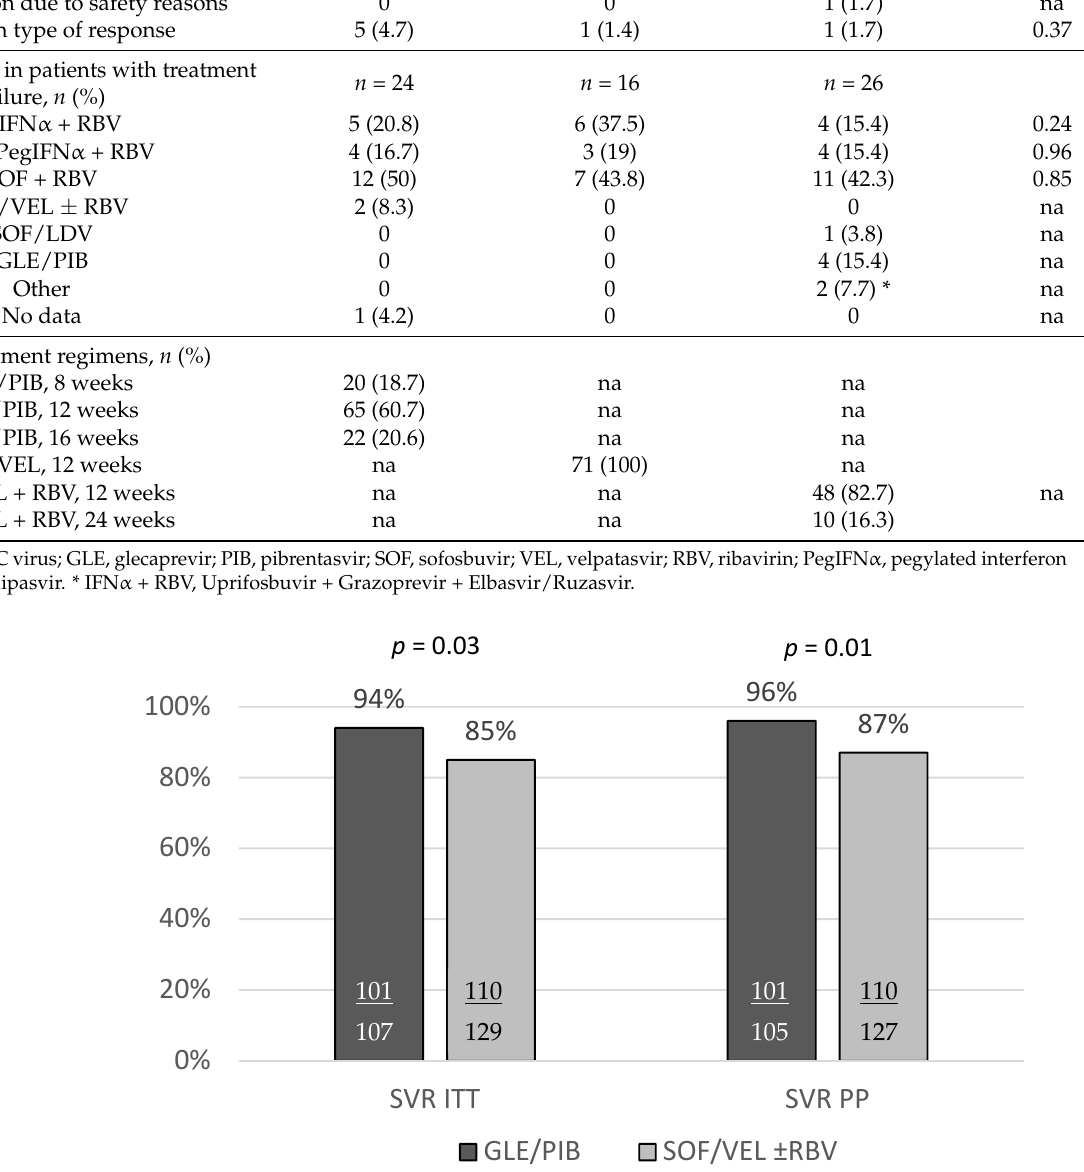
Table 3. Previous and current treatment characteristics of GT3 HCV infected patients with liver cirrhosis treated with pangenotypic regimens.